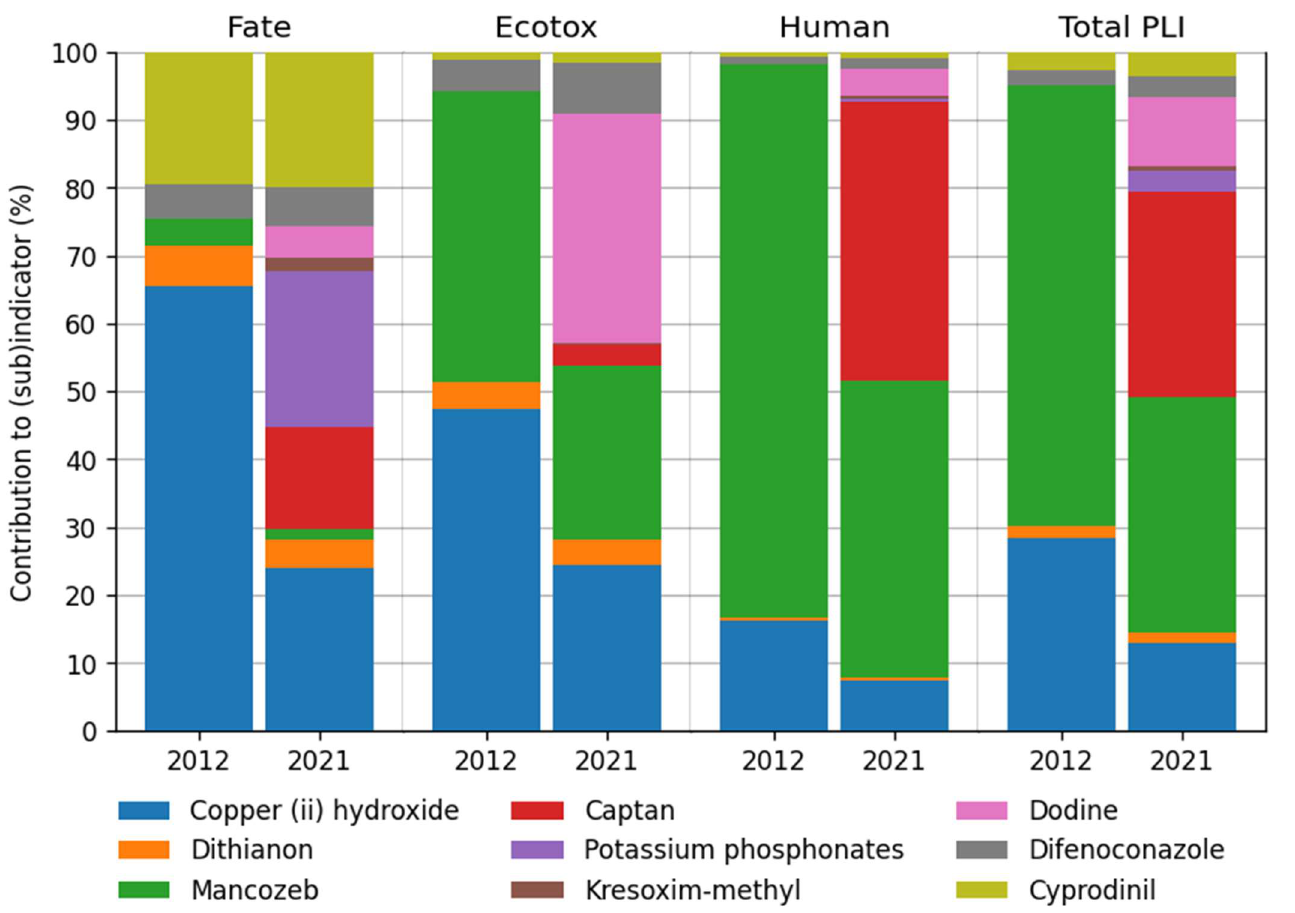
Figure 6. Contribution of active substances to sub-indicators: human health (PL HH ), ecotoxicology (PL ECO ), environmental fate (PL FATE ) and the total Pesticide Load Indicator (PLI) in six farms.